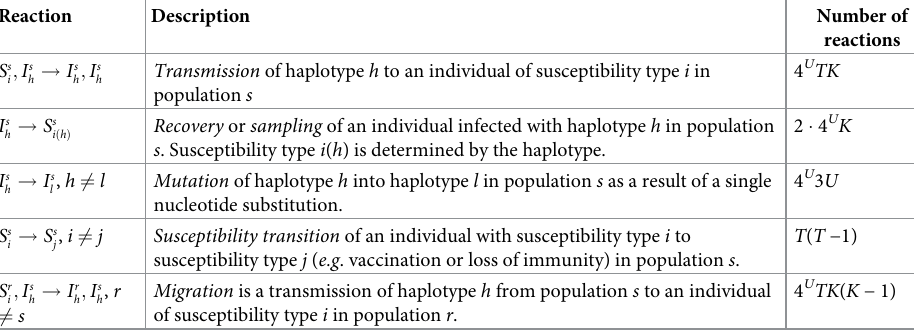
Table 1. The list of reactions and corresponding epidemiological events simulated by the Gillespie algorithm in our model, and the number of reactions in each category in function of the number of mutable sites U , number of susceptible individuals T , and the number of populations K .